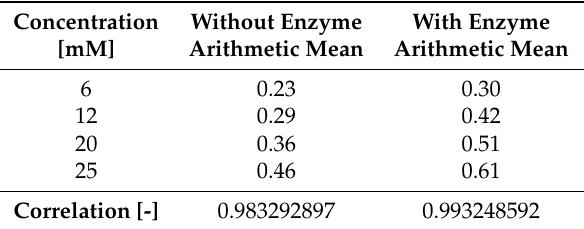
Table 4. Correlation table of Au